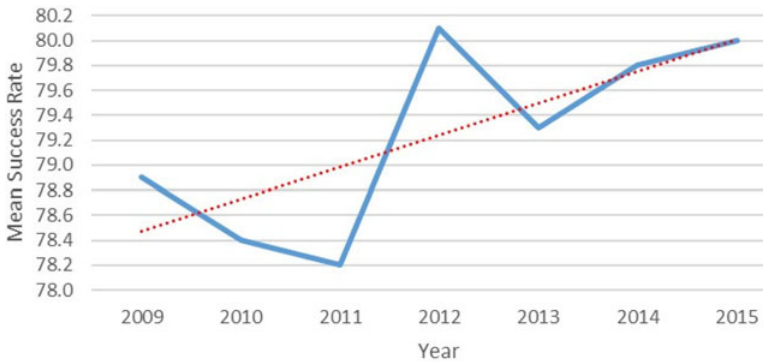
Fig. 1. Mean success rate: Go8, UniSA, Flinders, and Newcastle 2009 – 2015.